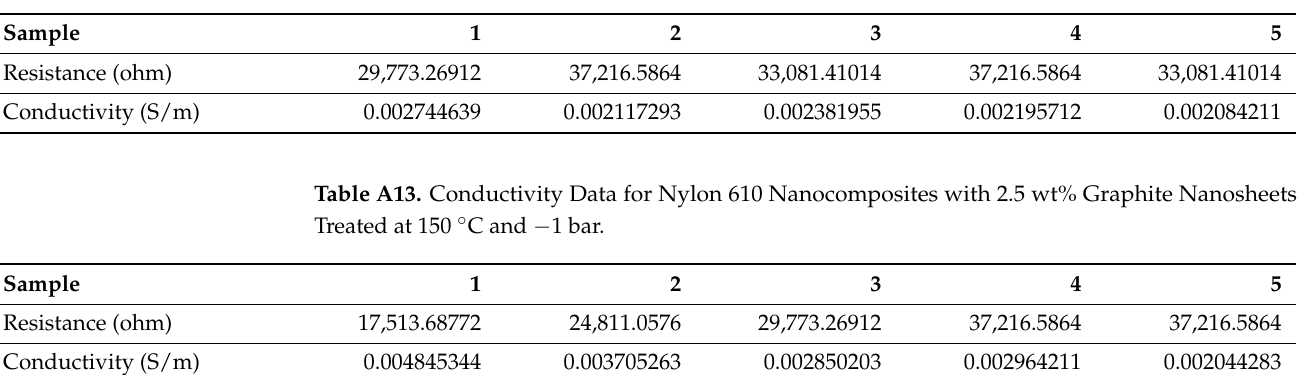
Table A12. Conductivity Data for Nylon 610 Nanocomposites with 1.5 wt% Graphite Nanosheets Treated at 150 ◦ C and − 1 bar.